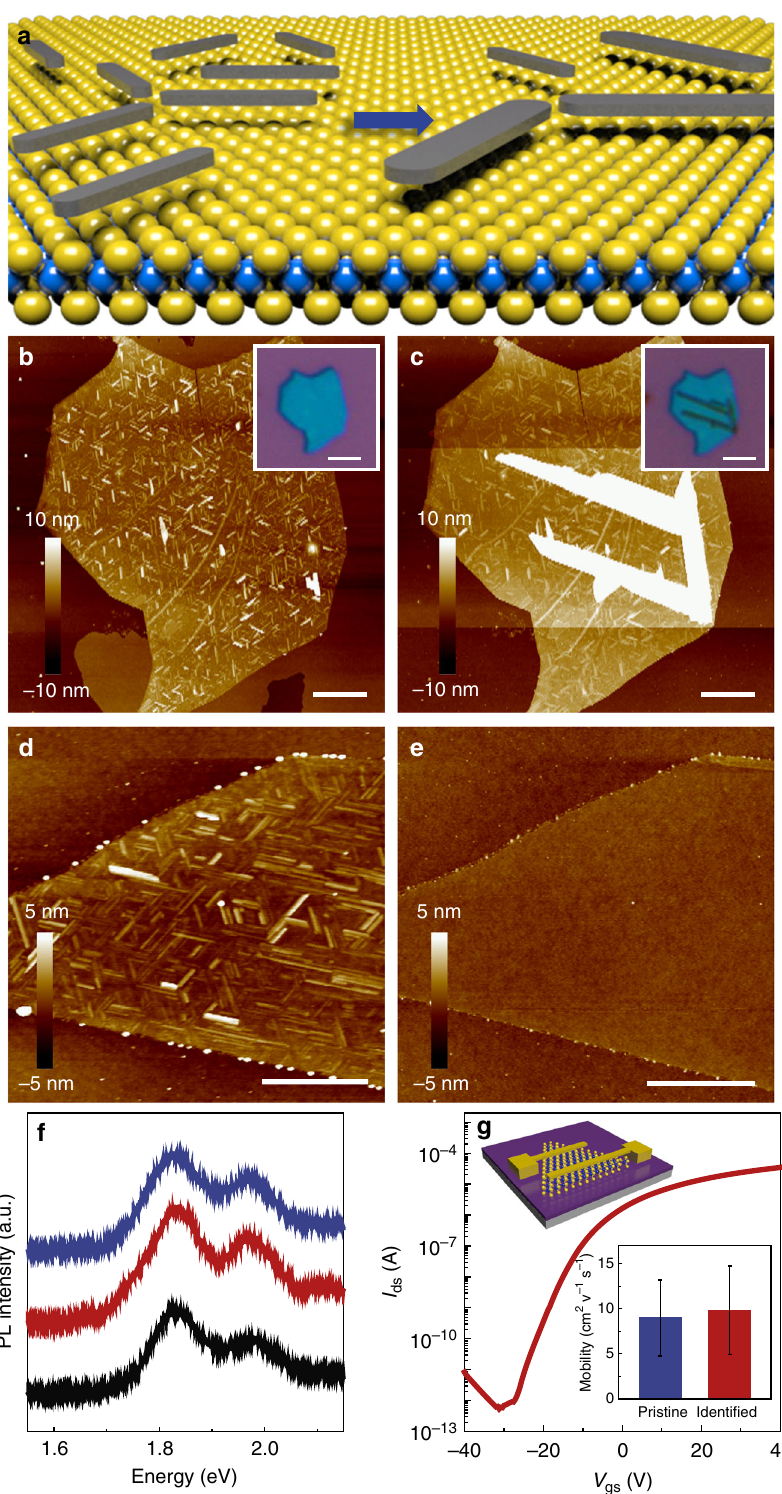
Fig. 4 Optical visualization and nondestructive removal of oleamide nanoribbons. a , Schematic for the evolution of nanoribbons driven by chemical potential. Small nanoribbons shrink while the large ones grow up. b , c AFM images of oleamide nanoribbons on a few-layer MoS 2 fl ake after 1 h and 8 days under ambient condition, respectively. Scale bar , 1 µ m. Inset Optical images. Scale bar , 2 μ m. d , e AFM images of a monolayer MoS 2 fl ake with oleamide nanoribbons before and after annealing in vacuum at 300 o C for 1 h, respectively. Scale bars , 500 nm. f PL spectra collected from the same monolayer MoS 2 : pristine ( black ), after oleamide self-assembly ( red ), and after the removal of nanoribbons ( blue ). g Typical I ds - V gs curve for CVD-grown monolayer MoS 2 fl akes after the removal of nanoribbons ( V ds = 1 V). Inset The averaged mobility of pristine ( blue ) and identi fi ed MoS 2 after the removal